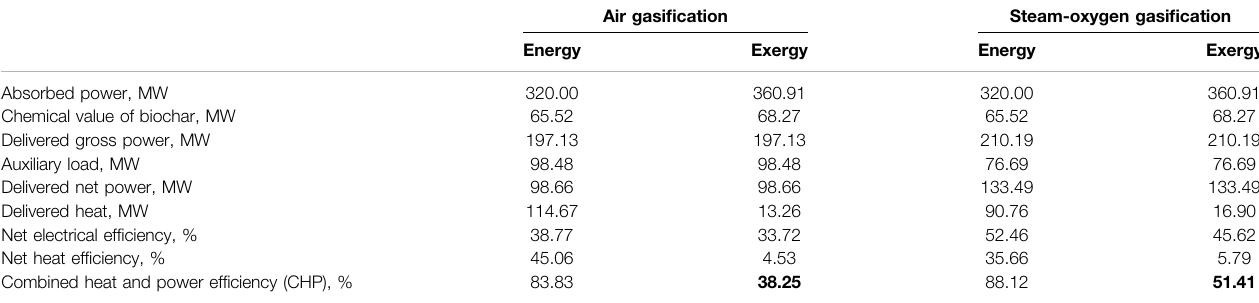
TABLE 10 | Energy and exergy analyses for biochar co-production of 10% by weight: comparison between the steam-oxygen gasi fi cation and the air gasi fi cation.